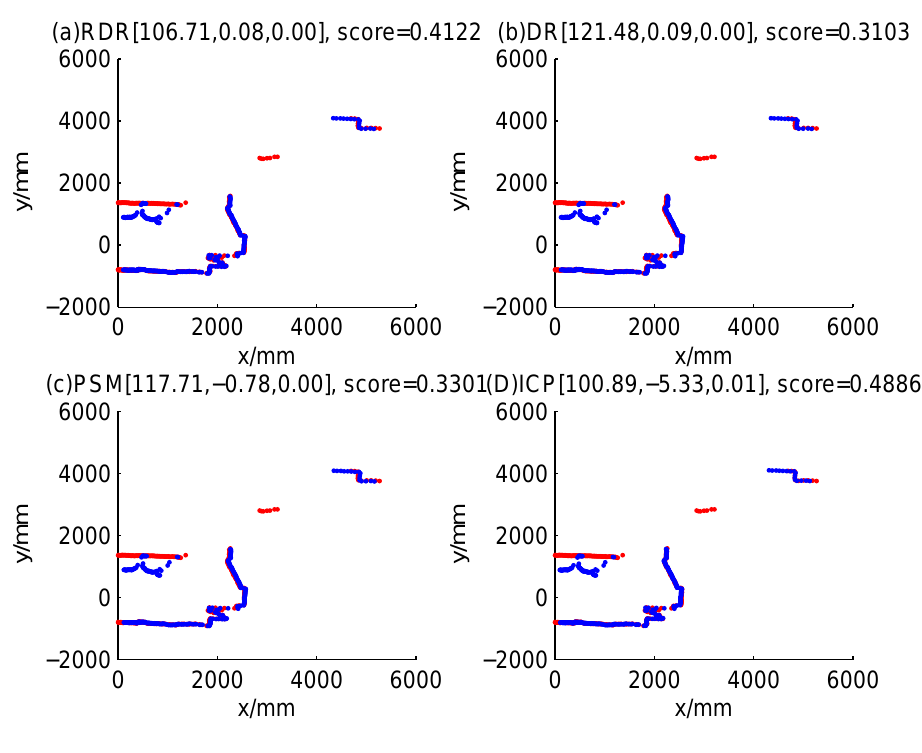
Figure 11. Robust dead reckoning result for Case 1a (time Step